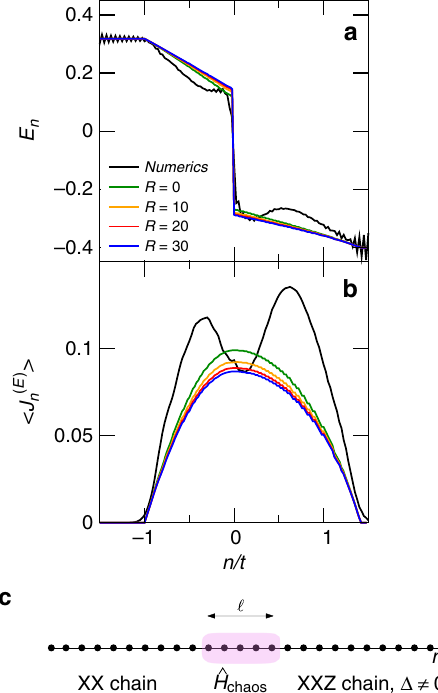
Fig. 6 Extended chaotic junction. a , b Analytic results from GHD for γ ¼ π = 4 in the energy-transport scenario for different values of the boundary resistance R , as indicated in the legend; a energy pro fi le; b energy current. T The value R ¼ 0 corresponds to a limiting situation where j T 0 (cid:3) (cid:3) þ j ! T = R is fi nite. The black line shows the numerical data for but ð T (cid:3) (cid:3) þ Þ t ¼ 40. c Cartoon of the setting where the two integrable Hamiltonians are joined via a chaotic Hamiltonian ^ H on ‘ chaos